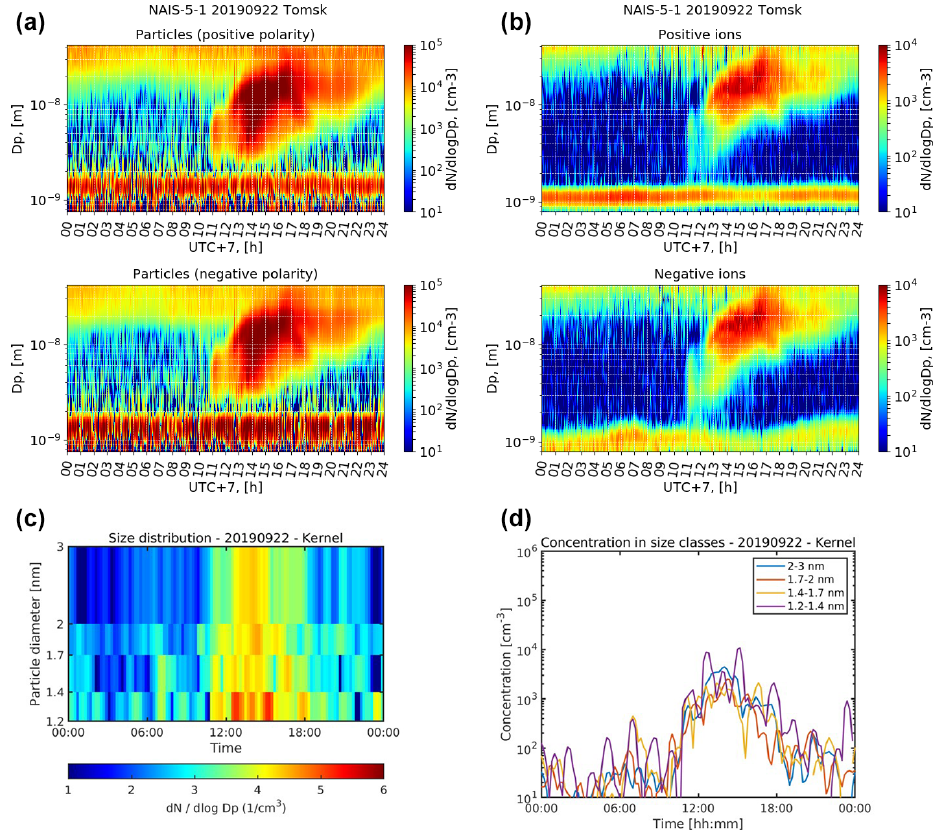
Figure 2. Example of results from the state-of-the-art aerosol instruments NAIS and PSM displaying an NPF event at Fonovaya station, Siberia, on 22 September 2019. Particles of different polarity, NAIS (a) , ions of different polarity, NAIS (b) , particle number distribution at the smallest sizes, PSM (c) , and number concentration of the smallest particles in different size bins, PSM (d)